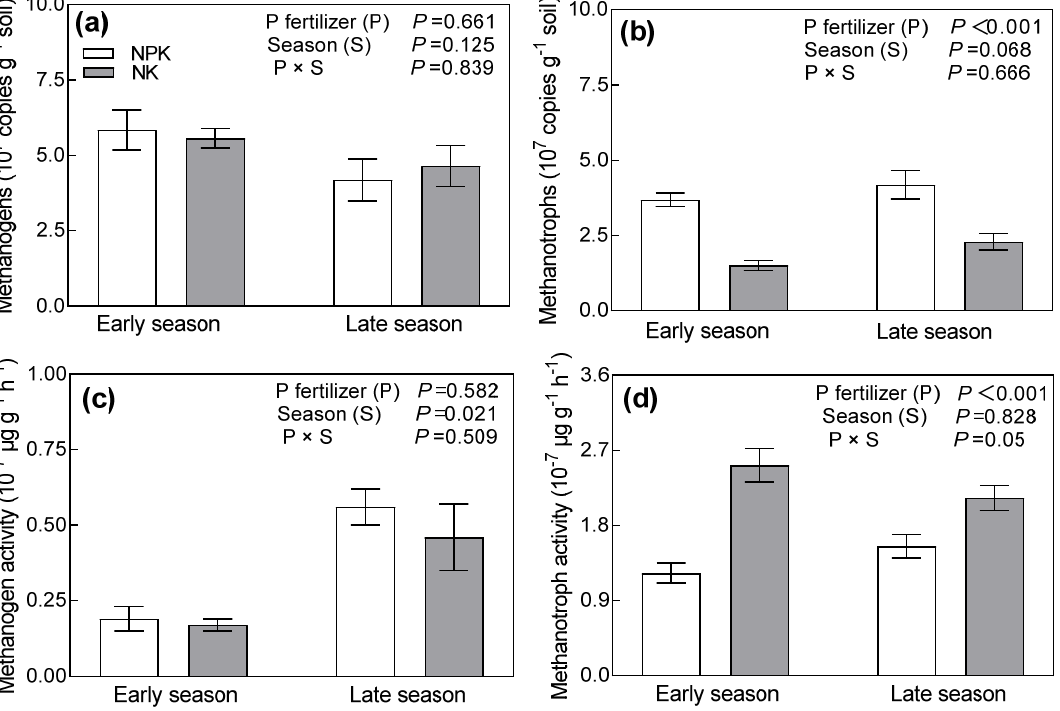
Figure 5. The abundances ( a , b ) and activities ( c , d ) of methanogens and methanotrophs under different long-term P addition treatments during early and late rice seasons. NPK: long-term N, P, and K fertilizers application; NK: long-term N and K fertilizers application. Error bars represent S.E. ( n = 3).